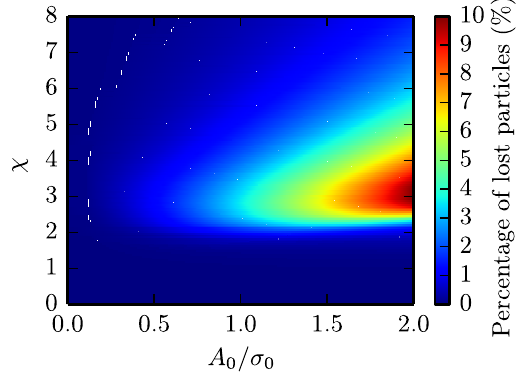
FIG. 5. Beam losses in simulations for the transverse decoherence in 2D beams with space charge. The particles with the amplitude above 3 . 5 σ 0 þ A 0 are counted as lost particles and FIG. 3. Time evolution of the beam oscillation amplitude for are removed from further calculations. The losses saturate after 0 . 01 , and 2D beams with different space charge, δ Q 250 turn. The simulation scan is performed for δ Q eff ¼ A 0 ¼ 0 . 1 σ 0 . Colors and the solid lines (contour lines) are from simulations. Dashed lines are given by Eq. (12). The vertical 22 . 5 turns [Eq. (8)]. white line represents N dec 0 ¼